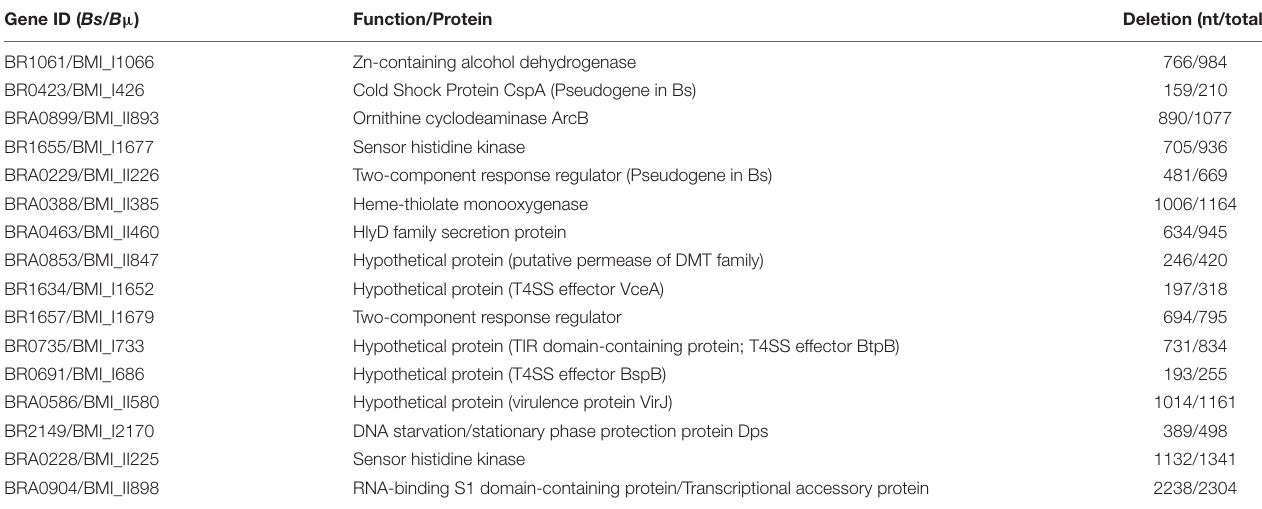
TABLE 1 | Genes selected for mutation in Brucella